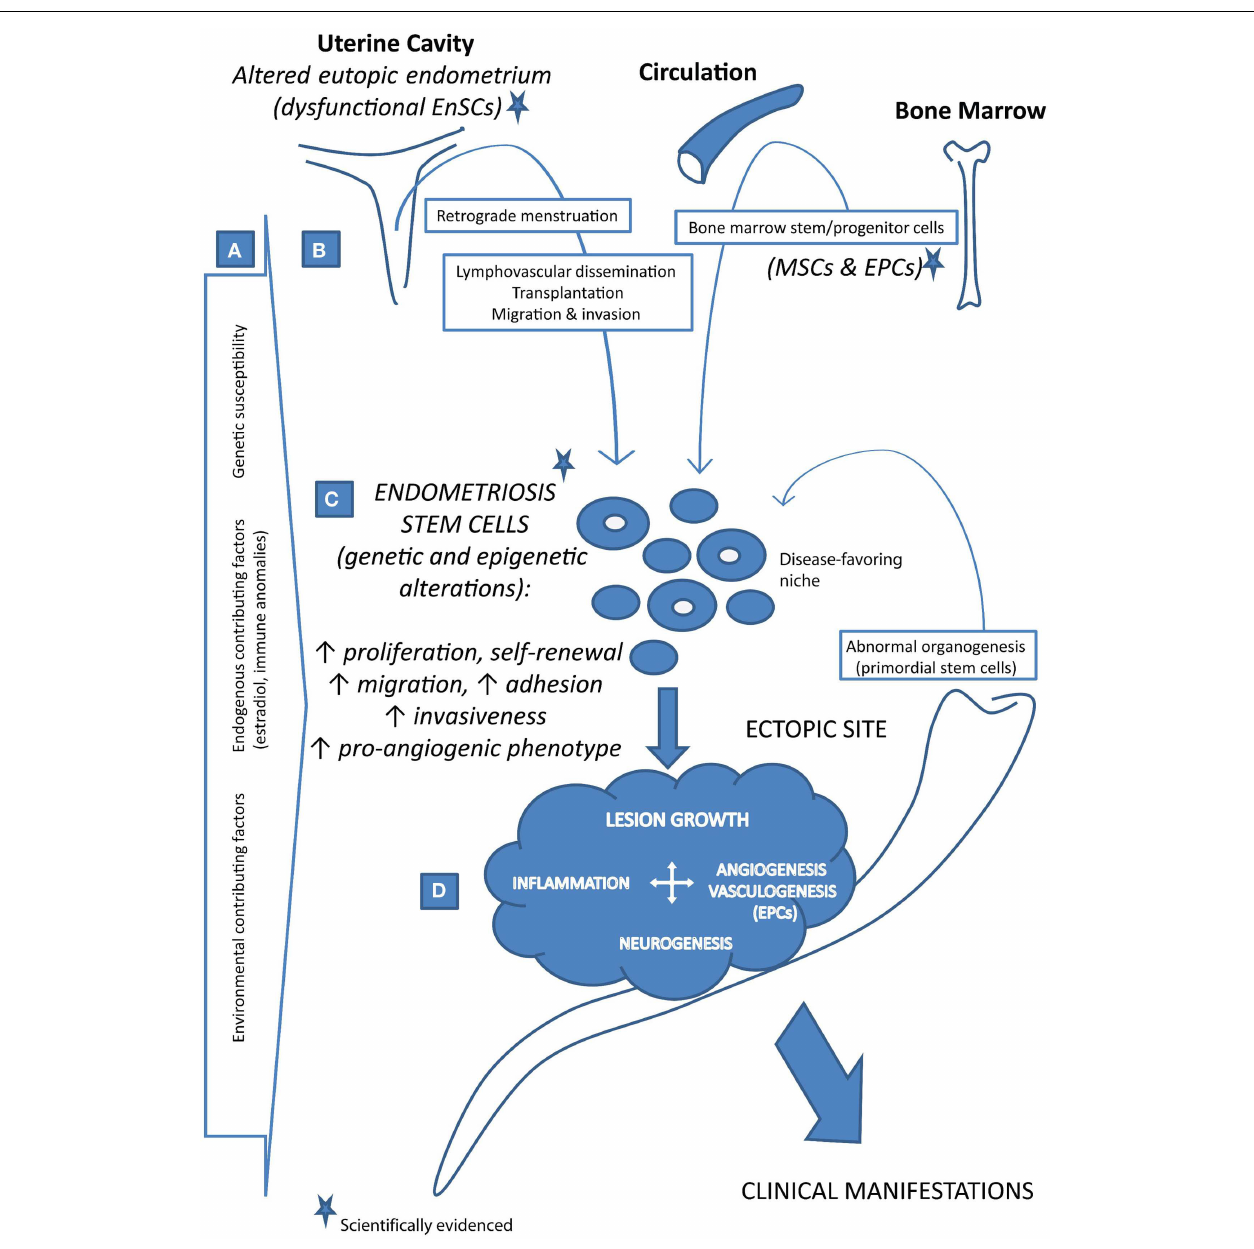
FIGURE 1 | Stem cell-based concept of the pathogenesis of endometriosis . (A) Endometriosis is a complex, multifactorial disease that develops in persons with genetic susceptibility and in the presence of various endogenous and/or environmental contributing factors. (B) Stem cells, which give origin to the endometriosis lesions under disease-favoring microenvironment conditions, may reach the ectopic sites via different routes as such as retrograde menstruation, lymphovascular dissemination, direct transplantation, migration and invasion, and abnormal cell migration during organogenesis. Besides the uterus (i.e., the eutopic endometrium containing endometrial stem cells, EnSCs , which